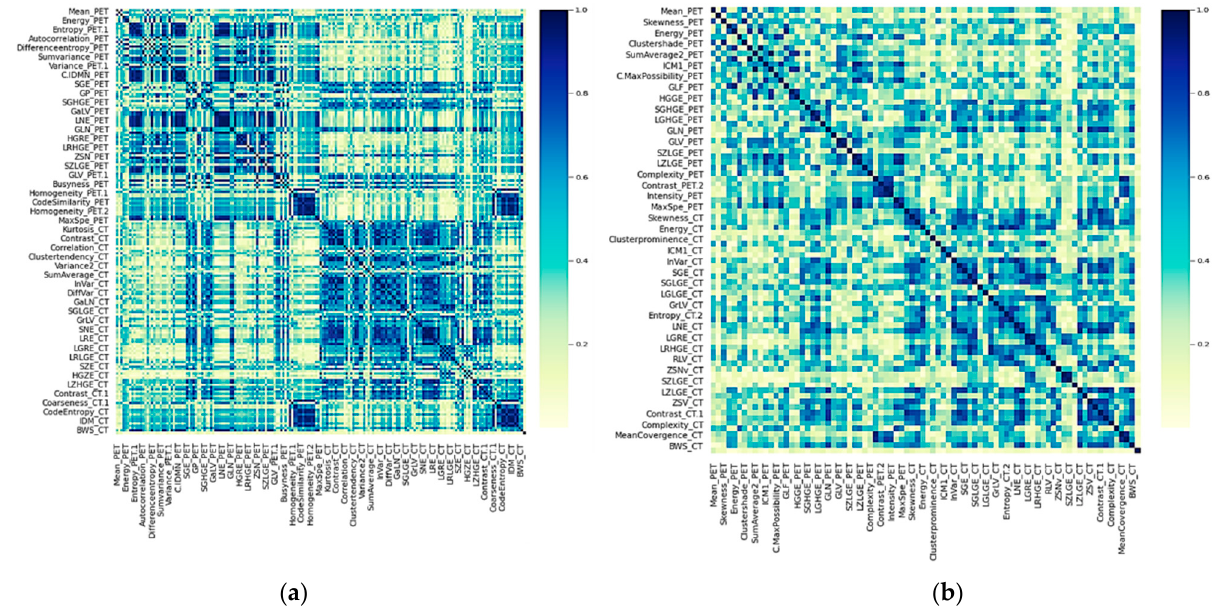
Figure 2. Heatmap of the absolute coefficient of Spearman’s correlations between clinical and imaging features. Darker blue colors indicate a higher correlation. ( a ) Before preprocessing and ( b ) After preprocessing, which consisted of elimination of one of two highly correlated variables.